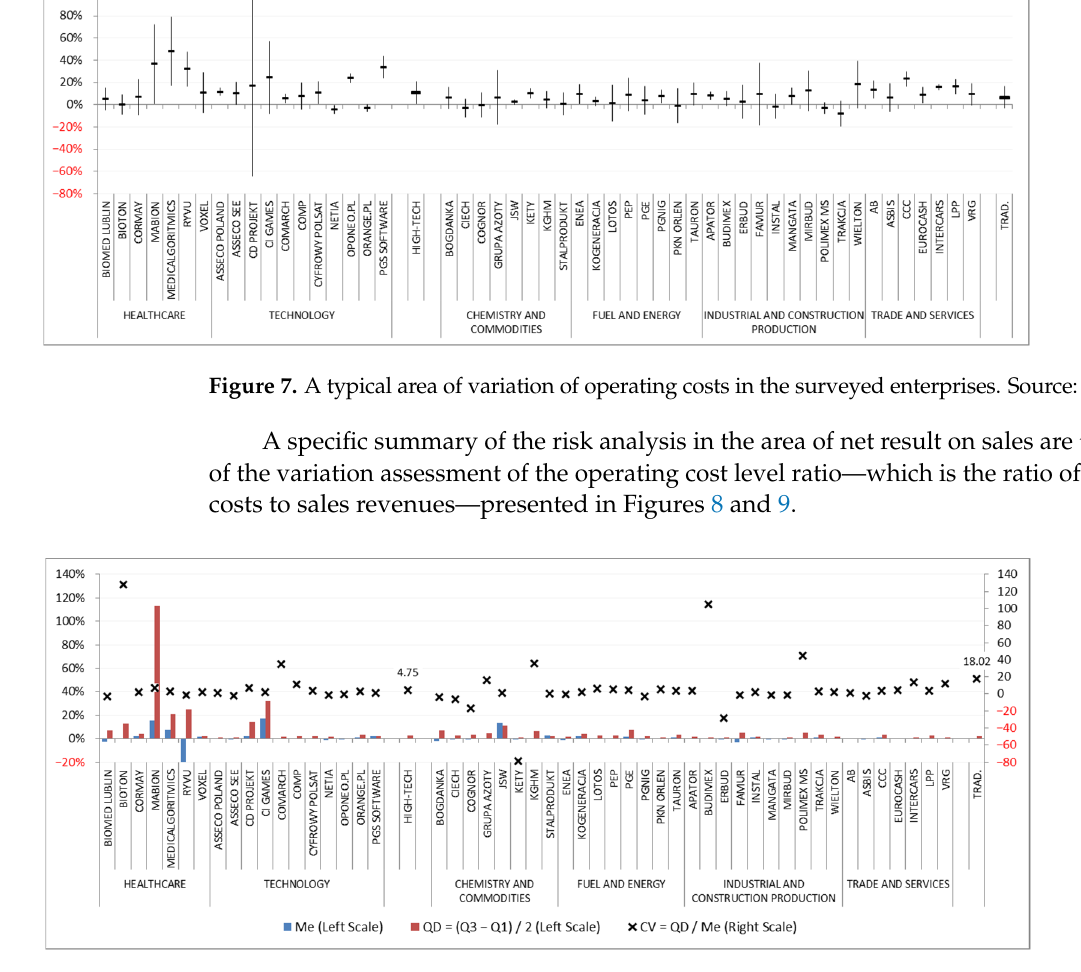
Figure 9. A typical area of variation of the operating cost level ratio in the surveyed enterprises . Source: own work. Taking into account the obtained results, it can be concluded that the operating cost level ratio has a higher variation in high-tech industries, primarily in the healthcare sector and in the computer games sector, which results from the aforementioned uneven distribution of operating costs and sales revenues over time. The ratios of the coefficients of variation are somewhat contradictory to this interpretation, but they are not confirmed in typical areas of variation, which are clearly much wider in the case of high-tech companies. Thus, regardless of the reason for the described results, they confirm the high variation of the result on sales, and thus the high risk of doing business in these sectors and enterprises. 4.2. Business Risk Assessment in the Context of Innovativeness: The Asset Perspective In the second part of the research, the assets of enterprises were referred to, treating their value as the foundation of enterprise development. Thus, Figures 10 and 11 present the results of the first stage of the analysis of total asset variation.